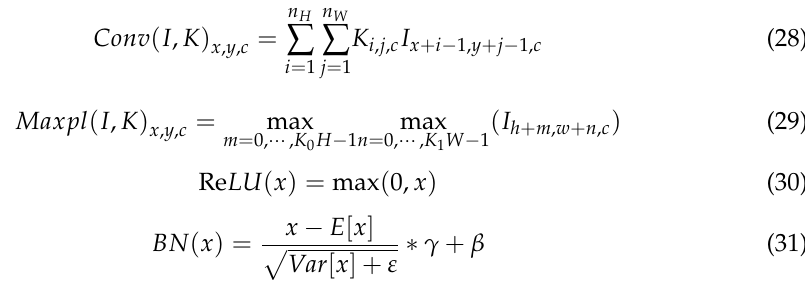
( b ) Figure 8. Experimental system: ( a ) control system; ( b ) experimental equipment. 3.2. Spark Feature The waveform data was filtered by median value and the image data was filtered by background difference algorithm.